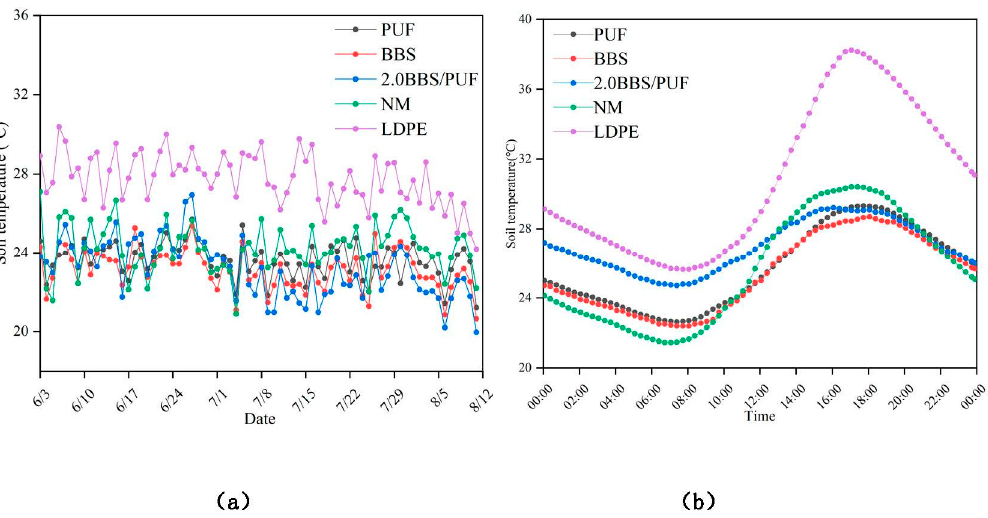
Figure 9. Temperature changes of different treatments, changes in soil temperature during the whole cultivation period ( a ), changes of soil temperature in 24 h, on a typical high-temperature day, 27 June ( b ).